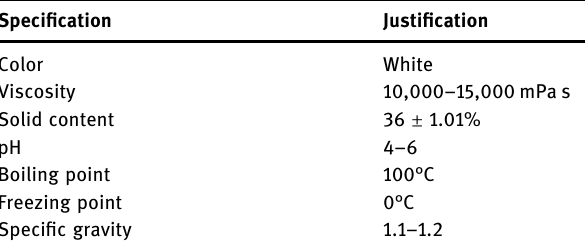
Table 1: Speci fi cation of PVAc Speci fi